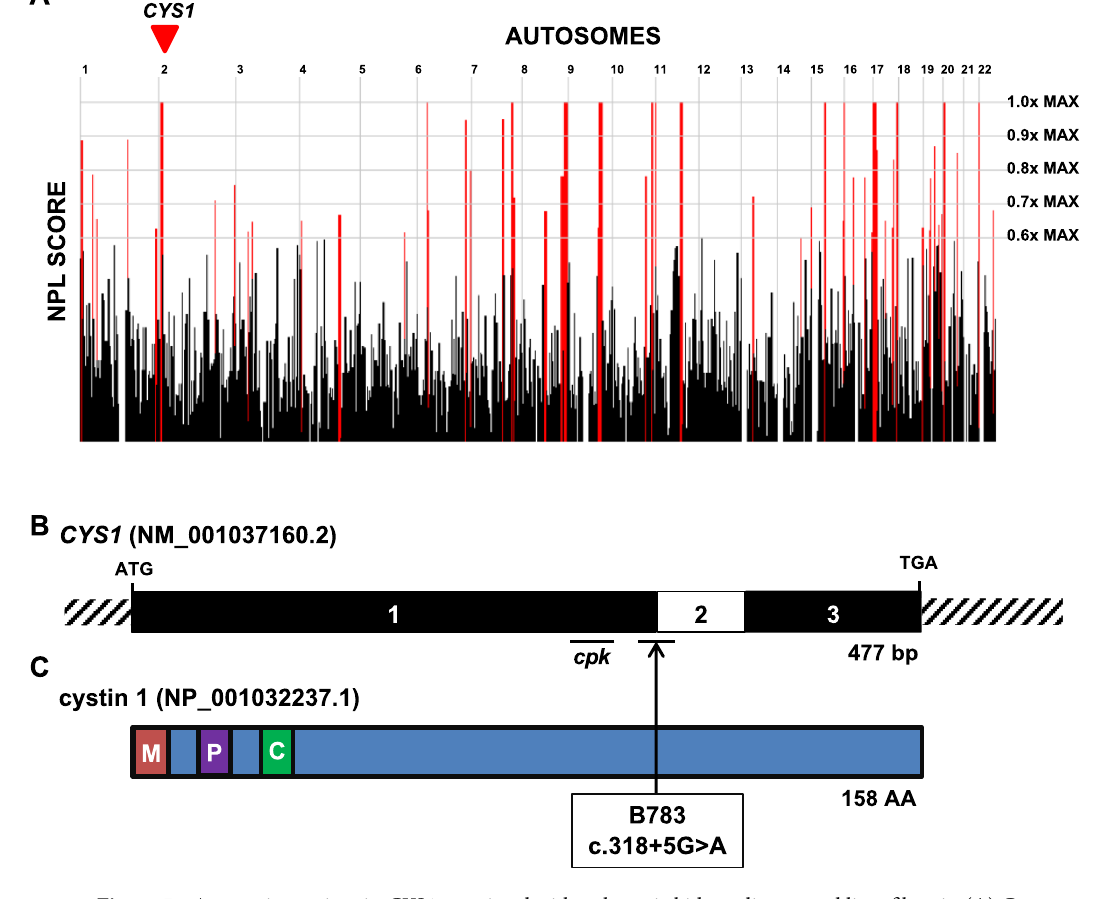
Figure 5. A recessive variant in CYS1 associated with polycystic kidney disease and liver fibrosis. ( A ) Genome- wide homozygosity mapping of B783 identifies homozygous peak regions. CYS1 is located within a peak region of chromosome 2 (arrowhead). ( B ) Exon structure of CYS1 cDNA. The locations of start codon, stop codons, and affected splice site (boundary exon 1–2) are indicated. The region of exon 1 deleted in the cpk mouse is also indicated. ( C ) Protein domain structure of cystin-1. A myristoylation site (M), polybasic region (P) and AxEGG motif required for targeting cystin-1 to the cilium (C) are indicated. Arrow indicates the boundary between protein regions encoded by exons 1 and 2. Abbreviations: AA, amino acid; bp, base pairs; C, cilium trafficking domain; M, myristoylation site; P, polybasic region.